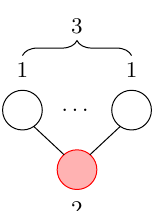
Figure 6 . P (3) quiver with SU(2) 3 (cid:26) Sp(4) global symmetry, b = (cid:0) 1, dim H M C = [1 3 ]